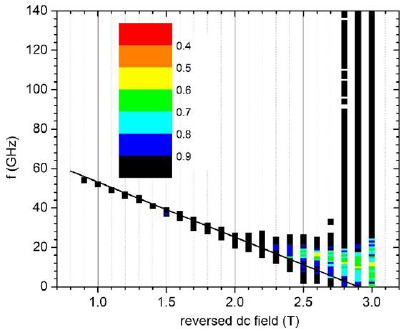
Figure 6. Conditions (exciting frequency vs. applied reversed field) under which reversal occurs within 1 ns for a CoPt disk with diameter D = 60 nm and thickness t = 4 nm, covered by a 2 nm Co 3 Pt layer. The color code represents the switching time in nanoseconds. A particular color is used for switching time, which is between the values indicated at its two edges. The solid black line represents the Kittel condition f = γ ( 2.9 T − H )